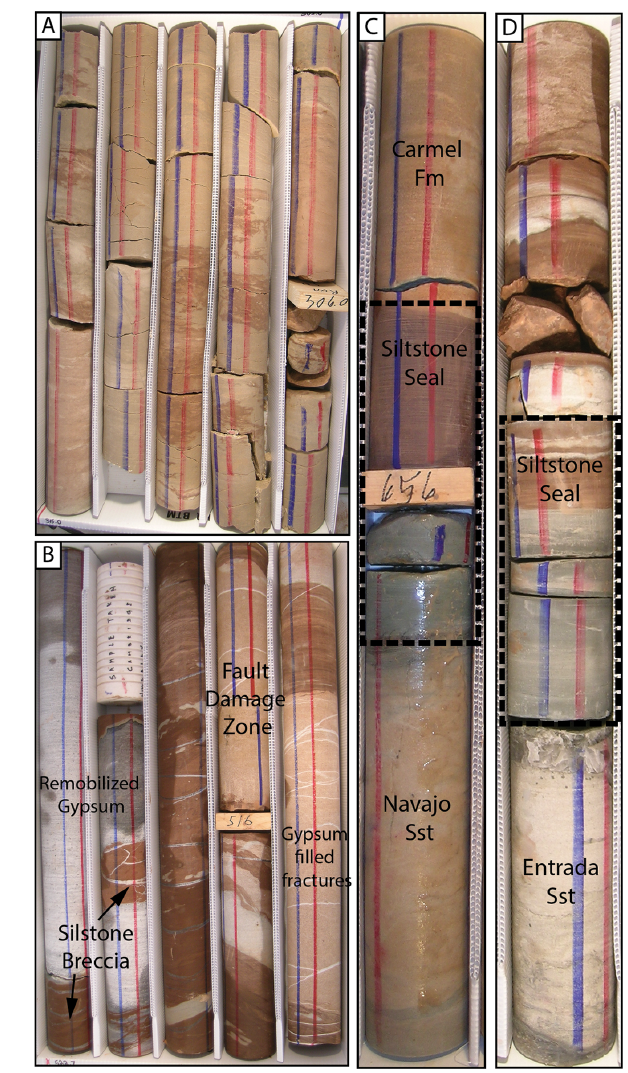
Figure 6. (A) Bleached basal sandstones of the Entrada Sandstone hosting CO 2 charged fluids. Fracturing of the core occurs at surface due to exsolution of CO 2 gas from the fluids held in core poros- ity. The relative permeabilities of water and gas result in a build-up of gas within the pore space, which expands causing the cores to break apart. (B) Sections of the fault core and damage zone from the Carmel formation showing fractured blocks of siltstone resid- ing in remobilized gypsum horizons and pervasive fracturing of the core in the footwall fault damage zone. (C) and (D) Siltstone- sandstone contacts from CO 2 -hosting sections of the Entrada and Navajo Sandstones showing bleaching and alteration of the origi- nally red siltstones over a 10cm distance by di ff usion of volatiles into the reservoir cap